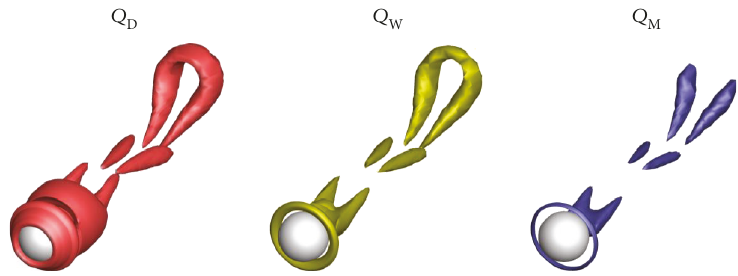
Q Q D , W , and M (isovalue